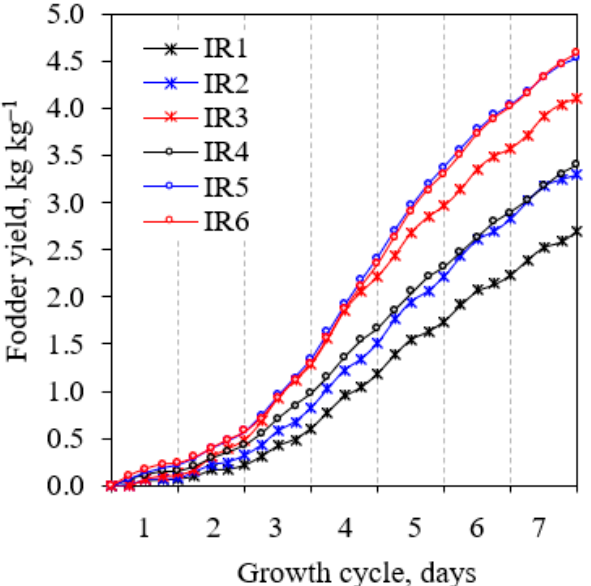
Figure 7. Dynamics of wheat fodder yields during a 7-day growth cycle under different irrigation scenarios. Four repetitions n were performed in each scenario.